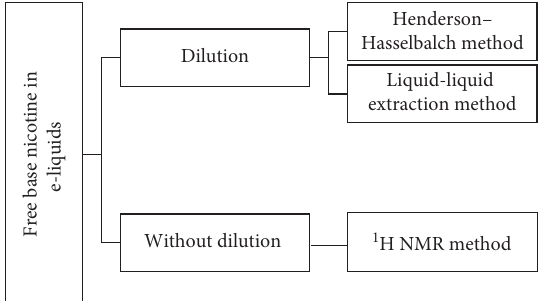
Figure 1: Schematic of methods for free base nicotine determi- nation in